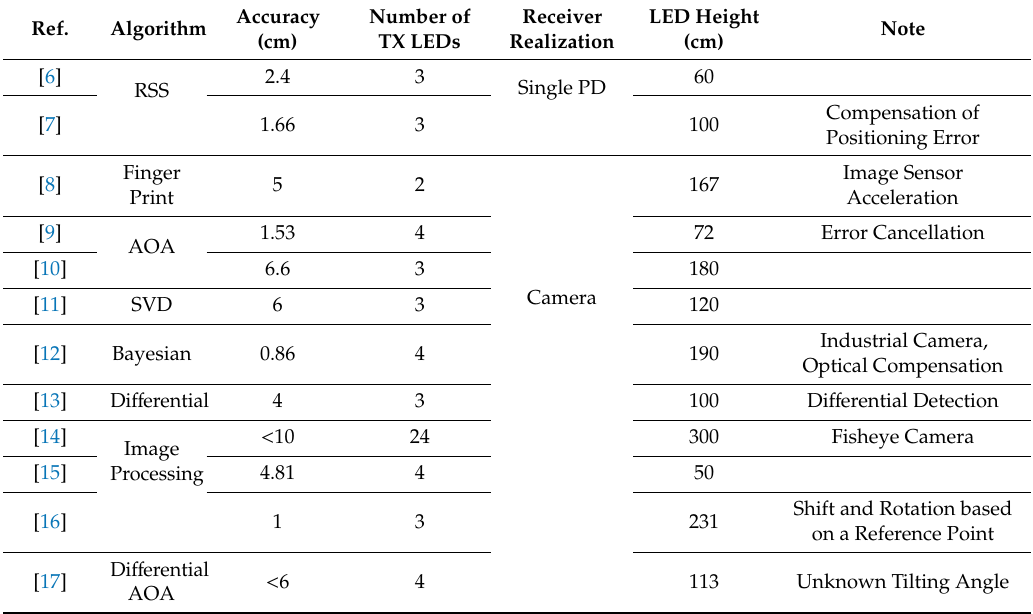
Table 1. Summary of current progress on indoor visible light positioning. RSS: received signal strength; AOA: angle of